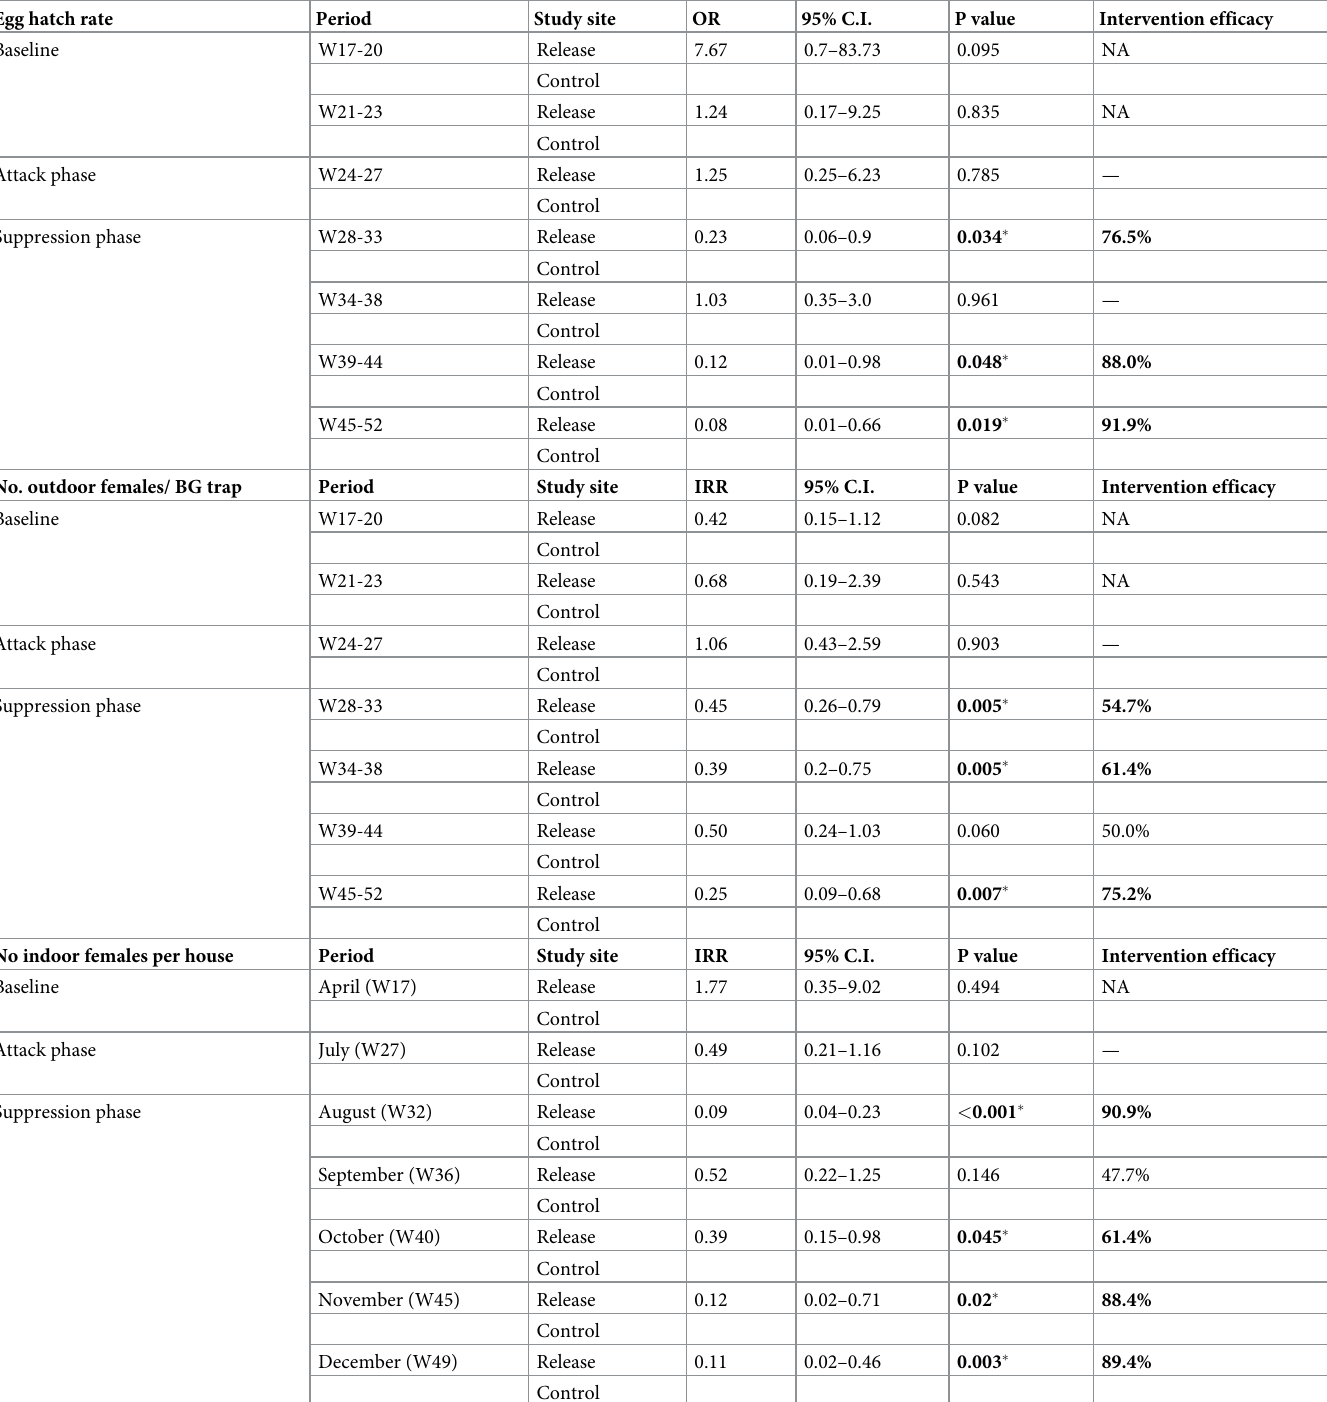
Table 1. Analyses of entomological indicators of population suppression between release (San Pedro Chimay) and control (Tahdzibiche´n) sites. Incidence rate ratios (IRR) and odds ratios (OR) with 95% confidence intervals are shown. Intervention efficacy ([1- OR or 1-IRR] x100) is